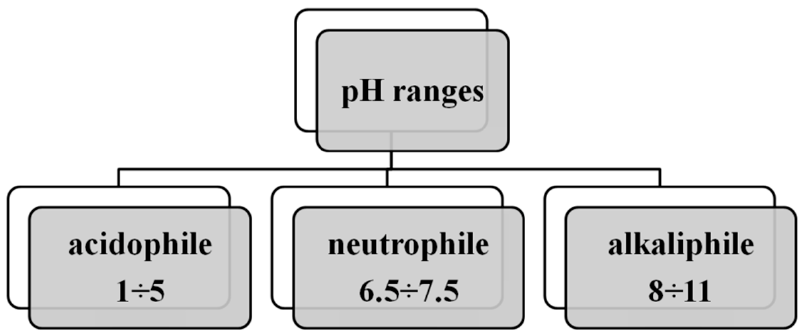
Figure 2. pH ranges preferred or tolerated by bacteria and fungi [10].